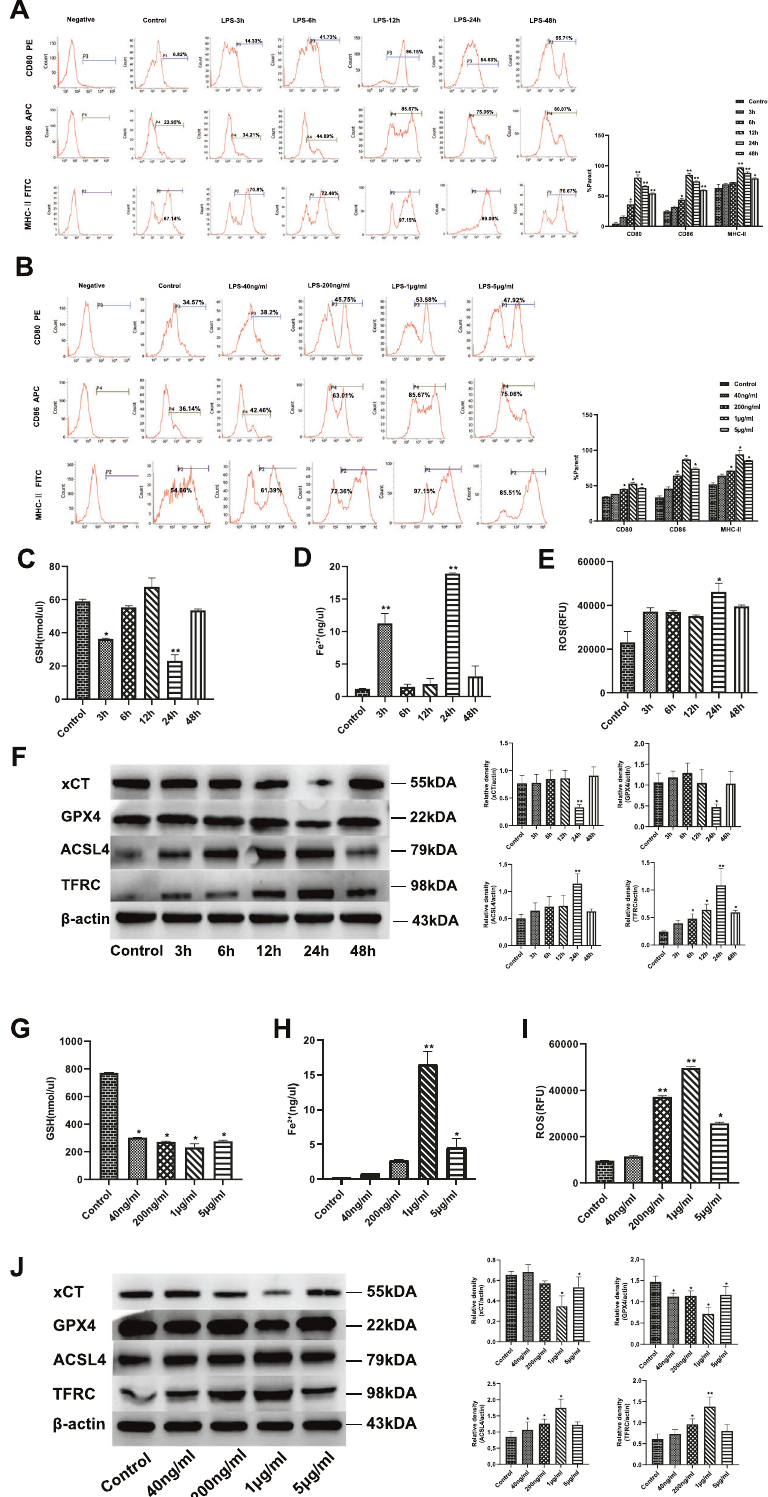
Fig. 1 Treatment with LPS upregulates ferroptosis and the percentage of co-stimulatory phenotypes of DCs. DCs were stimulated with LPS at various concentrations (40 ng/ml, 200 ng/ml, 1 μ g/ml, 5 μ g/ml) for different intervals (0, 3, 6, 12, 48 h). DCs cultured without LPS were de fi ned as controls. A , B Representative fl ow cytometric analysis was performed for CD80, CD86, and MHC-II expression on DCs. C – E , G – I Intracellular levels of GSH, Fe 2 + , and ROS in DCs were measured by detection kits. F , J Ferroptosis-related proteins were analyzed as presented in the methods. Data were presented as the mean ± SD of three replicates ( n = 3 per group). Statistical signi fi cance: * P < 0.05, ** P < 0.01 vs. the control